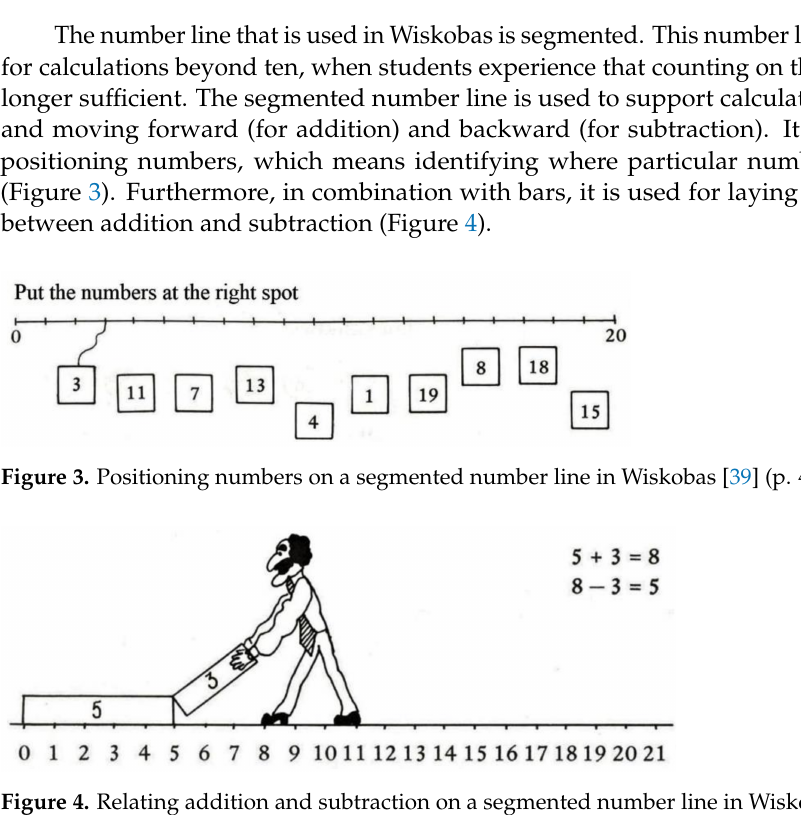
number line. It is emphasized that a number line with no or only a few marked points